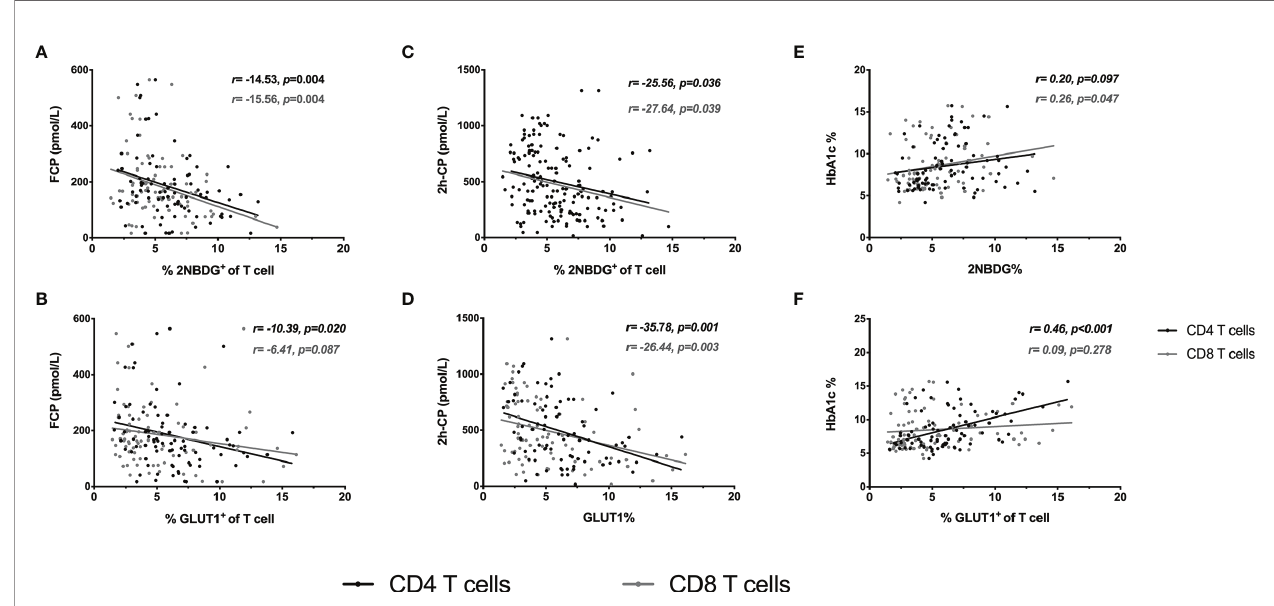
FIGURE 3 | Regression analysis of T cell glucose uptake with clinical characteristics. Linear regression analysis of T-cell glucose uptake vs FCP (A, B) , 2h-CP (C, D) and HbA1c (E, F) . The black line and dots represent CD4+ T cells, the gray line and dots represent CD8+ T cells. FCP, Fasting C-peptide; 2h-CP, 2 hours postprandial C-peptide; HbA1c, hemoglobin A1c; 2NBDG, 2-deoxyglucose; GLUT1, glucose transporter 1.